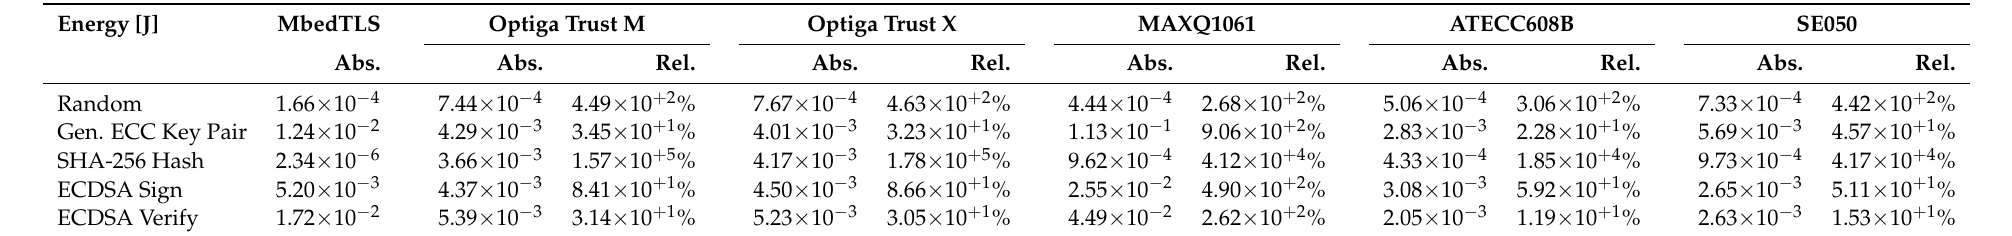
Table A6. Absolute energy consumption (abs.) of the node (MCU) during the cryptographic primitives using MbedTLS as a reference and absolute energy consumption of the node (MCU and secure element) during the cryptographic primitives using the secure elements with percentages relative (rel.) to reference (median of values, rounded to 3 significant digits, n =